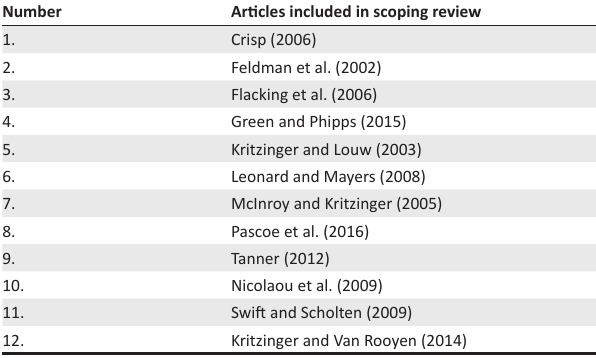
TABLE 1-A2: The format used to chart 12